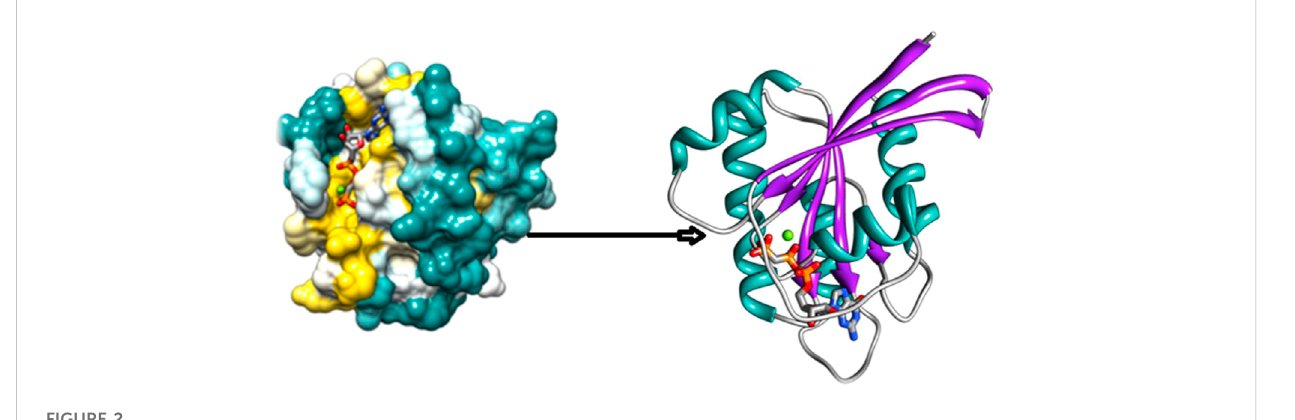
FIGURE 2 3D Structure of HRAS